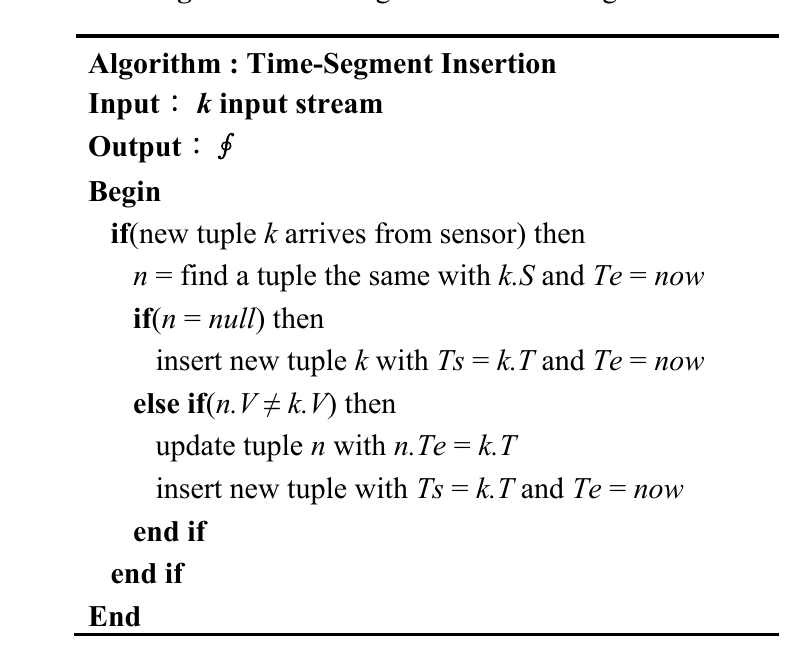
Figure 2. Time-Segment Insertion Algorithm.